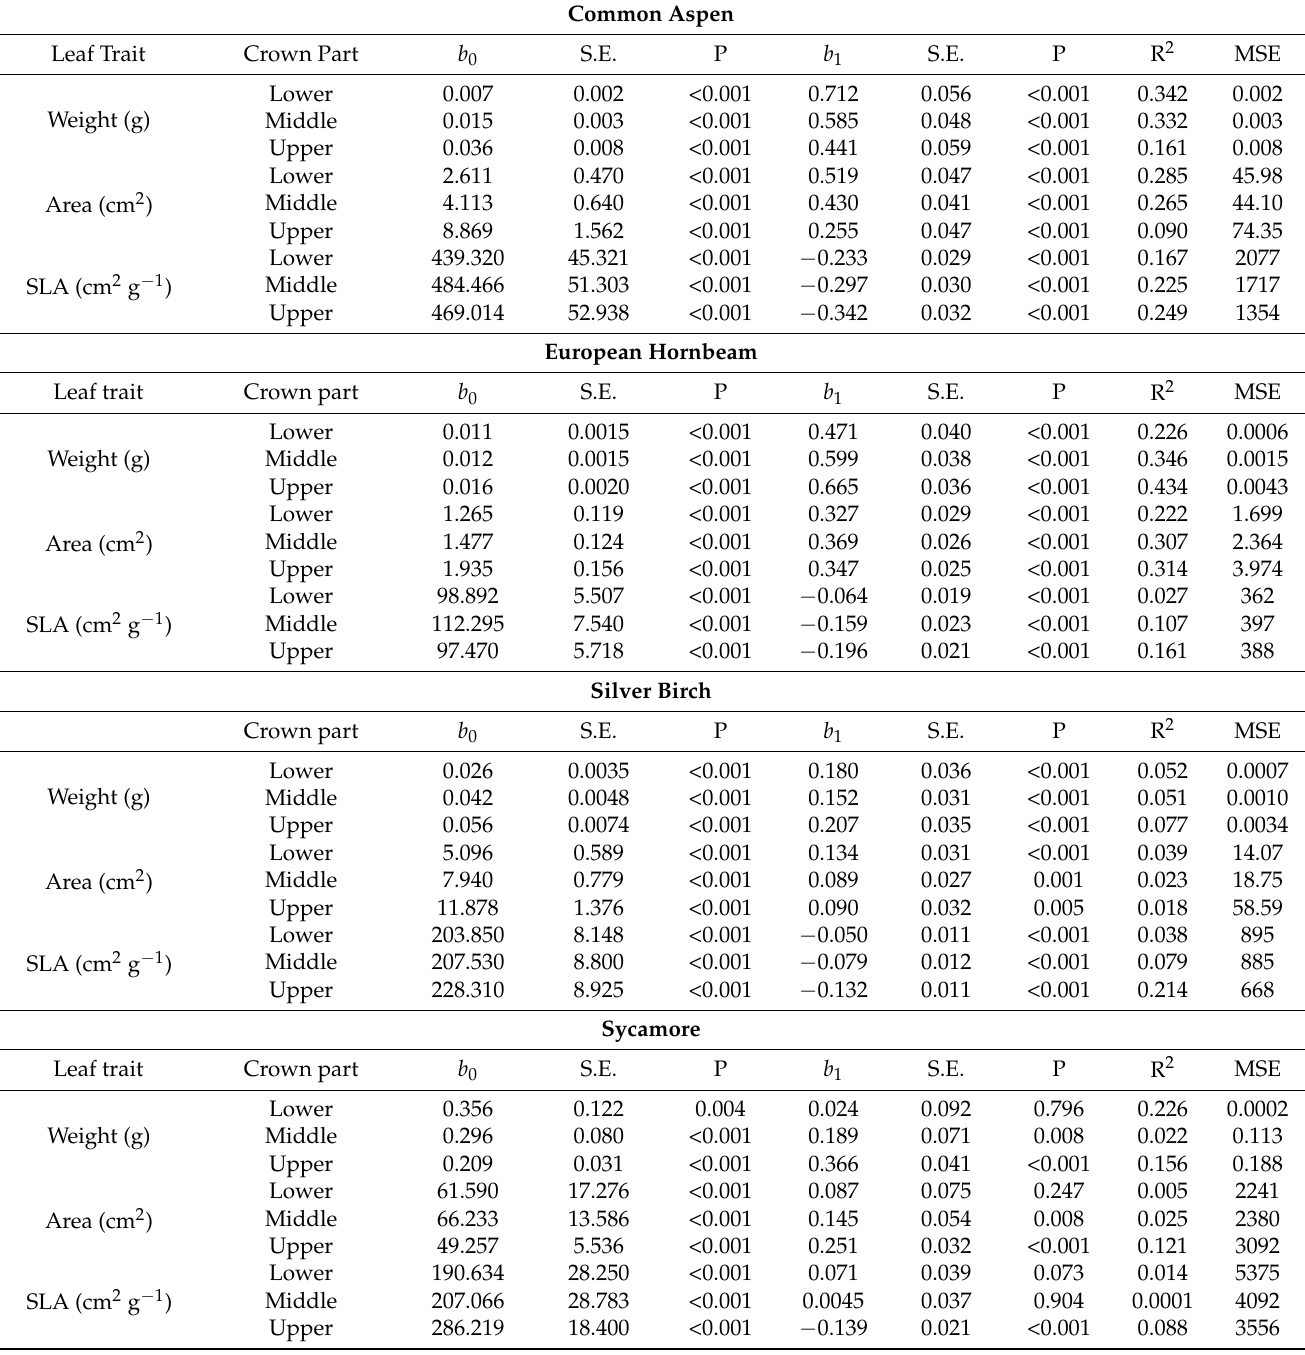
Table A1. Species-specific allometric models for leaf weight (g), leaf area (cm 2 ) and SLA (cm 2 g − 1 ) in three crown parts using diameter at stem base d 0 as a predictor (mm). Meaning of abbreviations is explained in Table